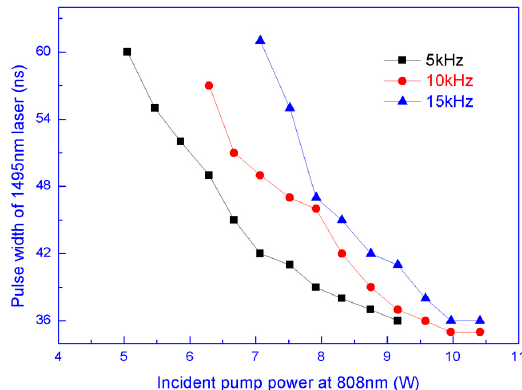
Figure 5. Pulse durations at the Stokes wavelength with respect to the incident pump power for the PRRs of 5 kHz, 10 kHz, 15 kHz.